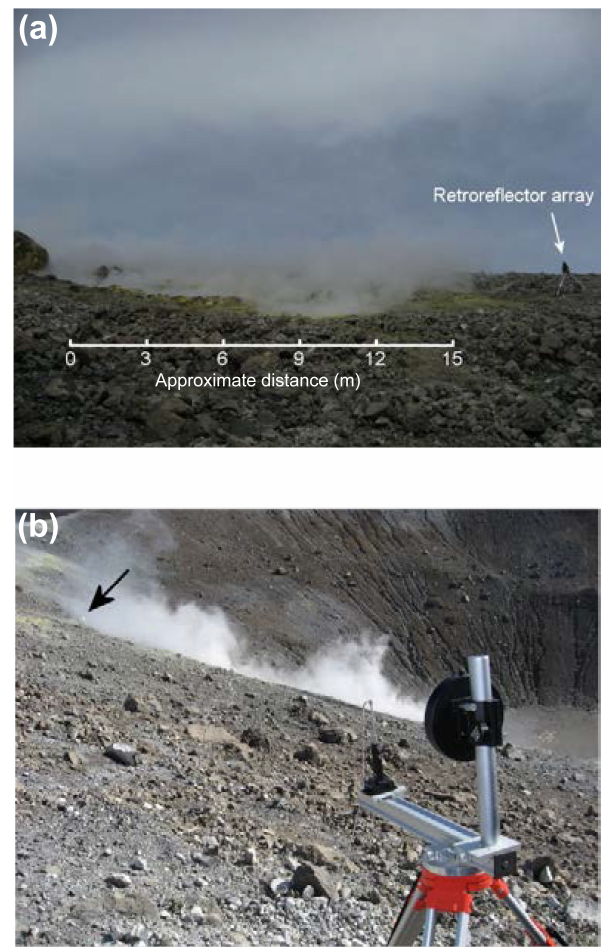
Figure 3. (a) Location of the retroreflector array during the first experiment on the island of Vulcano on 25 February 2010. The tele- scope was situated approximately 100m off to the left of this pho- tograph, but only the last 15m of the one-way optical path were filled intermittently with gas from the low-temperature fumaroles shown here, depending on the wind direction. (b) Configuration of the second experiment. Here, the retroreflector array (indicated by an arrow) was located approximately 200m from the telescope and farther down in the crater of the volcano. Gases originating from the higher-temperature fumaroles at the base of the crater would inter- mittently blow into the optical